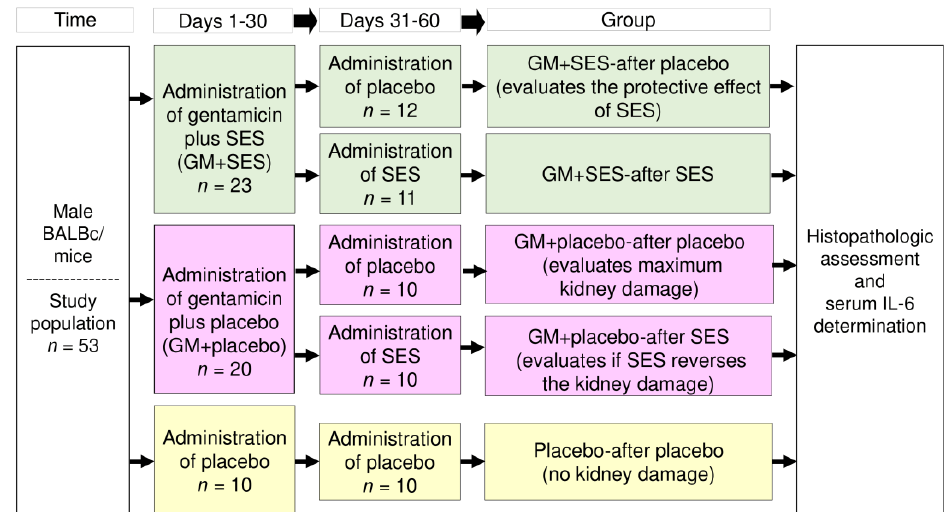
Figure 1. Schematic representation of the study. GM: gentamicin, SES: neutral electrolyzed saline, IL-6: interleukin 6.